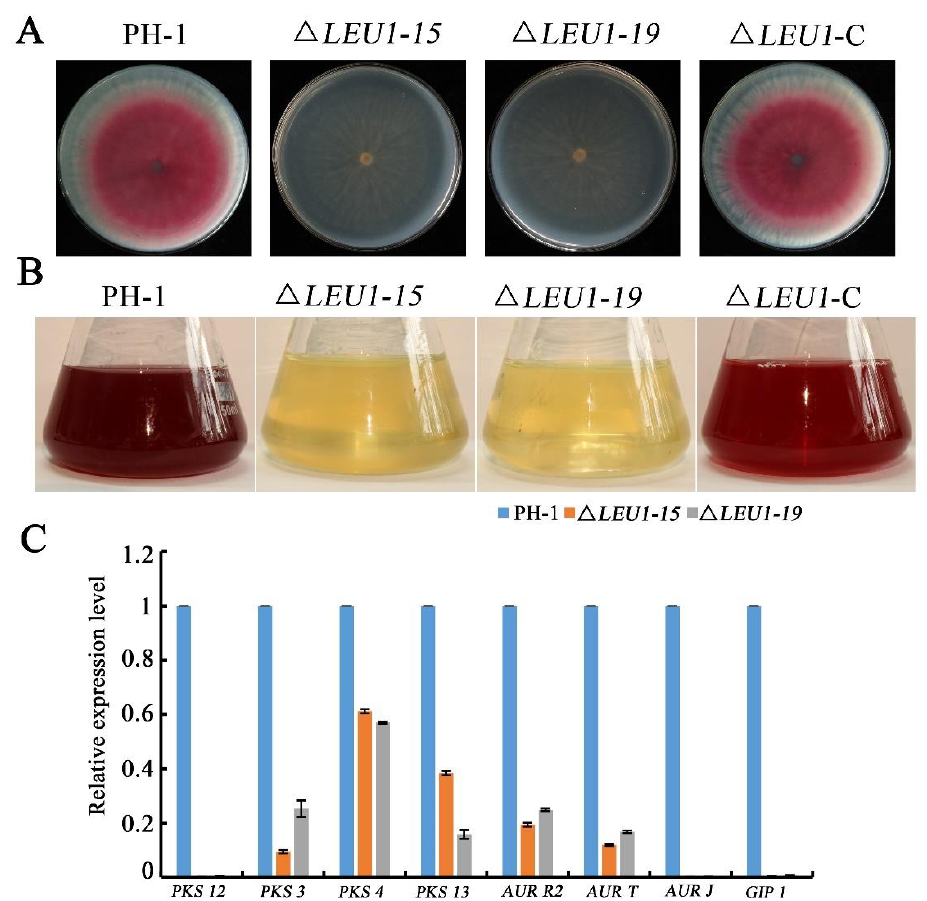
Figure 5. Pigment production and relative expression level of aurofusarin biosynthesis genes by the wild-type strain PH-1 and FgLEU1 deletion mutants. ( A ) Red pigment aurofusarin formation by the wild-type PH-1, FgLEU1 deletion mutants, and complementation strains cultured on PDA at 25 °C for 4 days. ( B ) Red pigment aurofusarin formation by the wild-type PH-1, FgLEU1 deletion mutants, and complementation strains cultured in liquid medium in flasks containing 50 mL of PDB at 180 rpm, 25 °C for 5 days. ( C ) Relative expression levels of aurofusarin biosynthesis-related genes. GAPDH was used as an internal control. Gene expression in PH-1 was set to 1.0 ( P < 0.05).